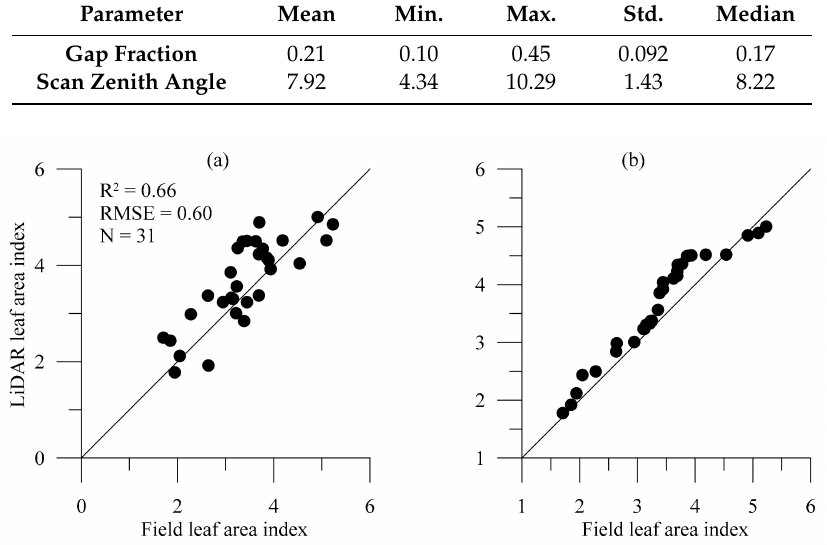
Table 2. LiDAR gap fraction and scan angle to derive the plot-level LiDAR LAI.